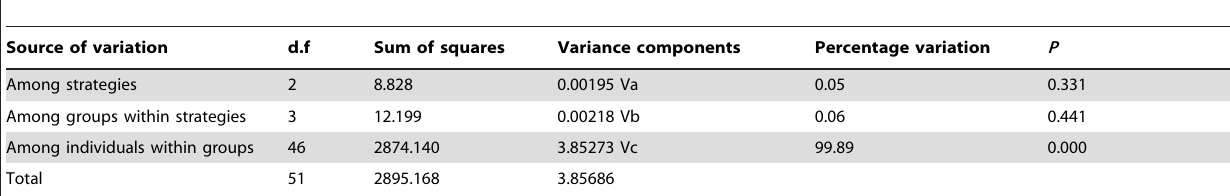
Table 4. Result of Analysis of Molecular Variance (AMOVA) comparing the six sampling groups and the three overwintering